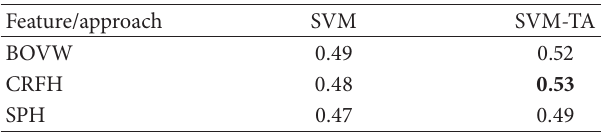
Table 1: IMMED dataset: average accuracy of the single feature